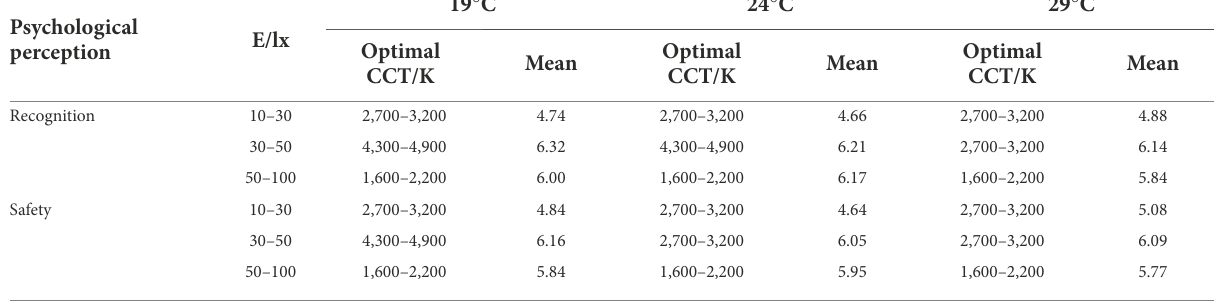
TABLE 2 The optimal CCT and mean values of participants’ scores correspond to recognition and safety at different temperatures. Psychological